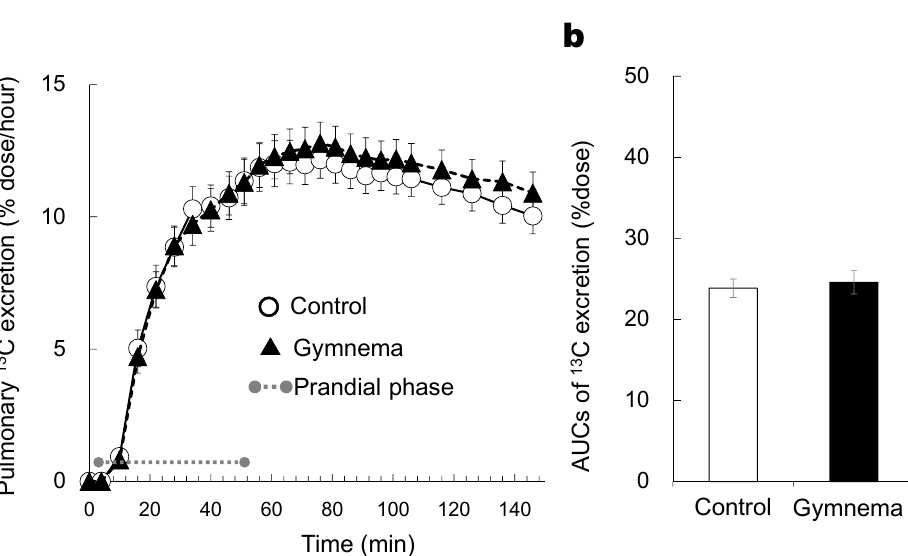
Figure 3. Time courses of 13 C excretion responses ( a ) and the areas under the curve of 13 C excretion rate for 146 min ( b ) during and after consuming sweet-tasting foods. Grey circles at both ends of dotted gray line denote the limits of prandial phase (consumption of sweet-tasting food). Mean ± SE.